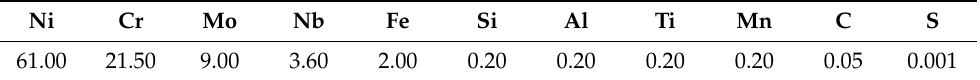
Table 1. Chemical composition of the Inconel 625 used in this work (wt.%).